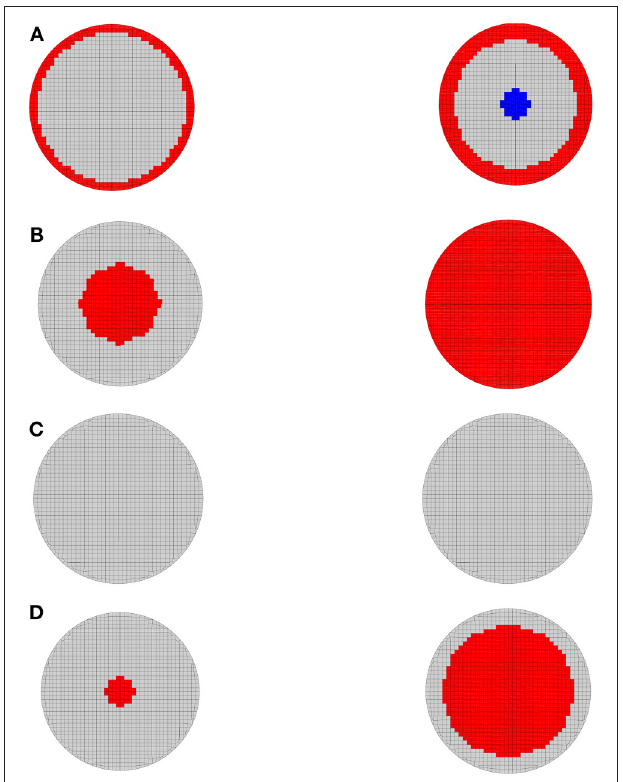
FIGURE 13 | Cracking propagation of a circular slab on the: (A) top-clamped, (B) bottom-clamped, (C) top-simple supported, and (D) bottom-simple supported.